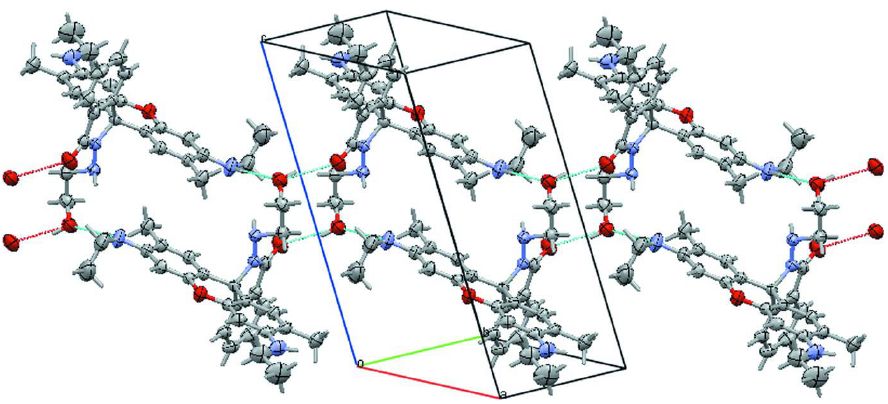
Figure 2 The molecular packing of the title compound showing the double stranded hydrogen bond connected chains. Dashed lines indicate hydrogen